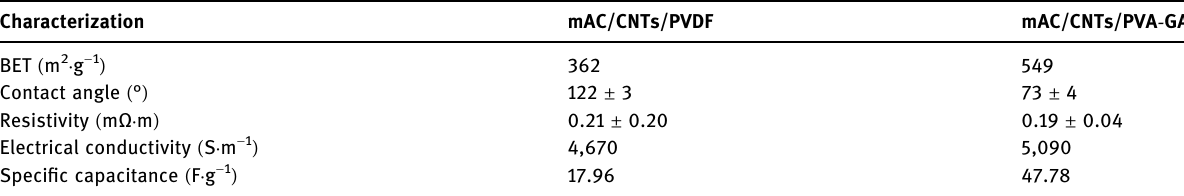
Table A2: Characterization of mAC/CNTs/PVDF and mAC/CNTs/PVA - GA